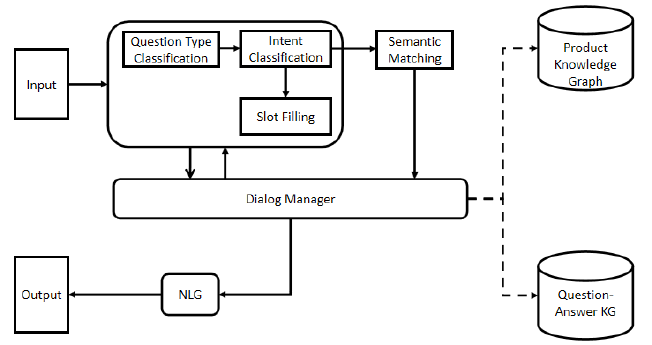
Figure 2. Dialog system